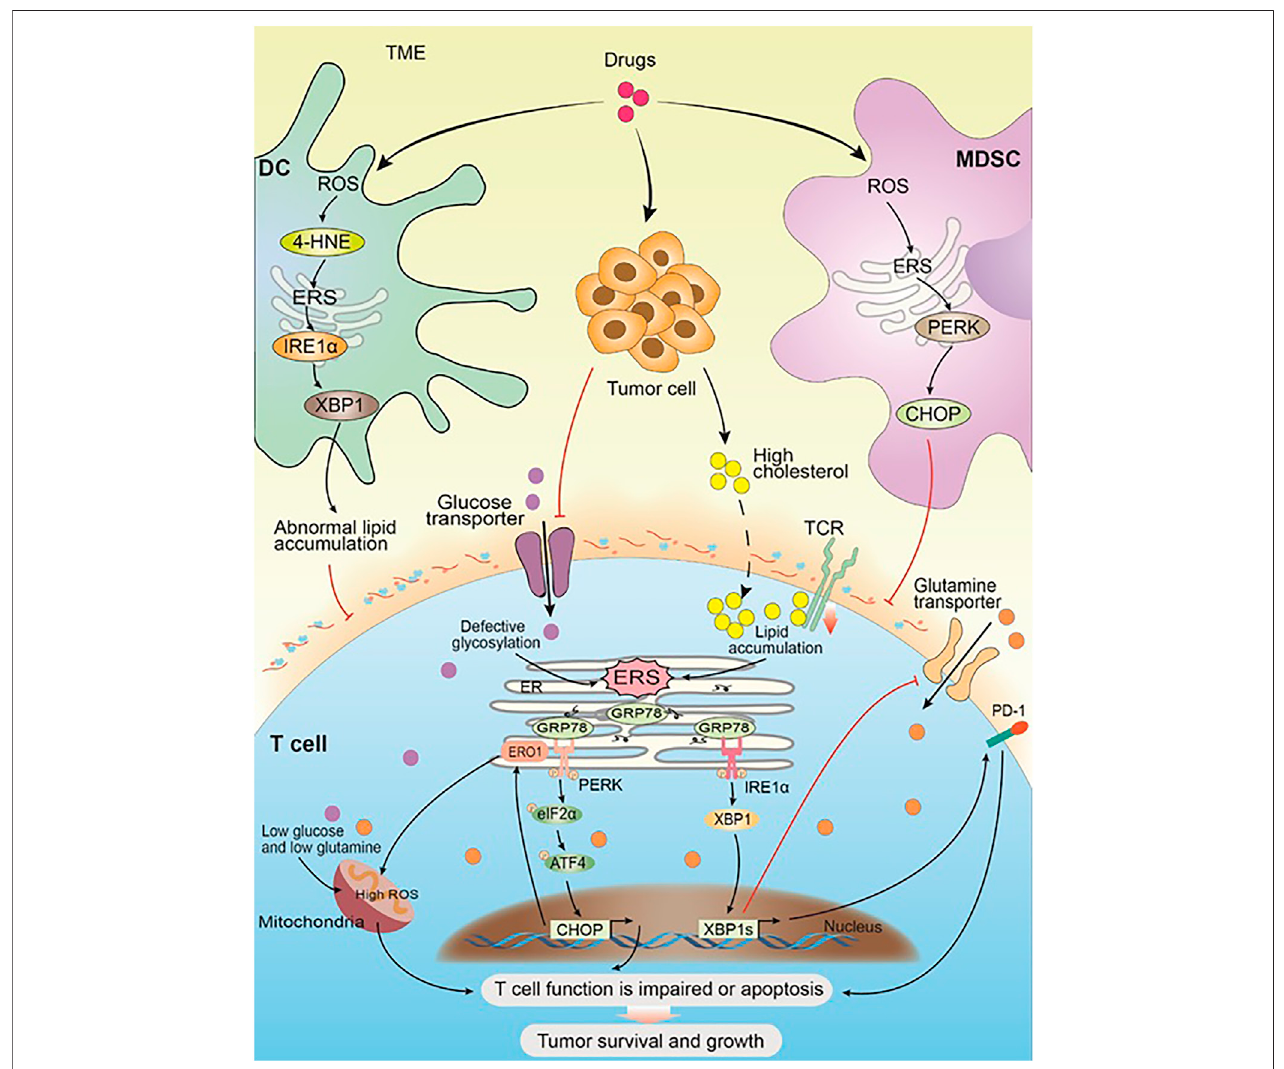
FIGURE 2 | ERS within immune cells promotes solid tumor cell survival and progression. Drug and the progress of tumor cause changes in the TME and trigger ERS inthe immune cells. In DC, the high expression ofROSleadsto anincreaseof4-HNE, whichin turninduces ERS and its downstreamIRE1 α -XBP1 arm, resulting in abnormal lipid accumulation, which inhibits the antigen presentation oftDCs to T cells. In MDSC, the high expression of ROS activates ERS, and its downstream PERK- CHOP arm inhibits the normal function of T cells. Glucose restriction in solid tumor microenvironment triggers ERS by impairing optimal N-linked protein glycosylation in T cells, which in turn inhibits glutamine transporter – mediated glutamine in fl ux. Both glutamine and glucose fl ow into the mitochondria get reduced as a result,andthemitochondrialrespiratoryfunctionandtheT-cellfunctiongetimpaired.Solidtumor-derivedorexogenouscholesterolleadstolipidmetabolismdisordersin CD8 + T cells, triggering the high expression of internal ERS and XBP1, which in turn promotes the high expression of PD-1 and leads to T-cell apoptosis. Meanwhile, cholesterol inhibits TCR signaling by binding to the transmembrane region of the TCRb chain and disrupting TCR clustering, which inhibits the normal function of T cells and leads to immunosuppression. Chronic PERK induces the downstream target ERO1 through the ATF4-CHOP axis, leading to a large amount of ROS accumulation and impaired mitochondrial function. Impaired T-cell function or apoptosis promotes the survival and development of solid tumor